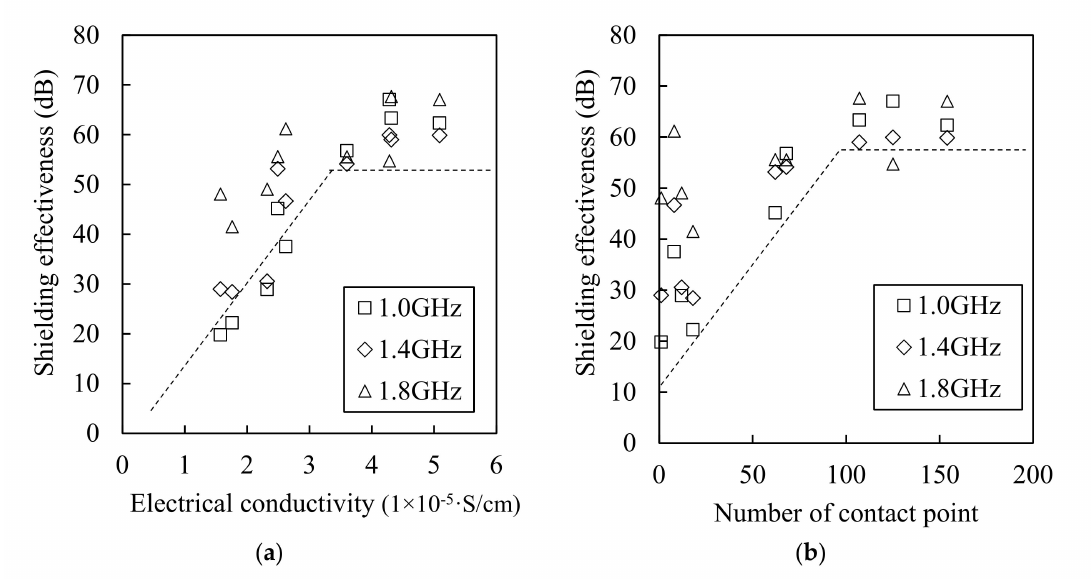
Figure 16. Relationship between shielding e ff ectiveness as functions of electrical conductivity ( a ) and number of contact points ( b